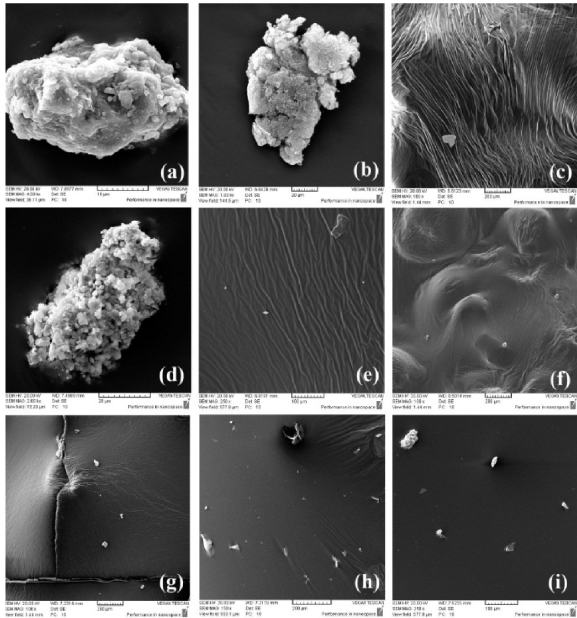
Fig. 4. SEM images of various additive types of the study: